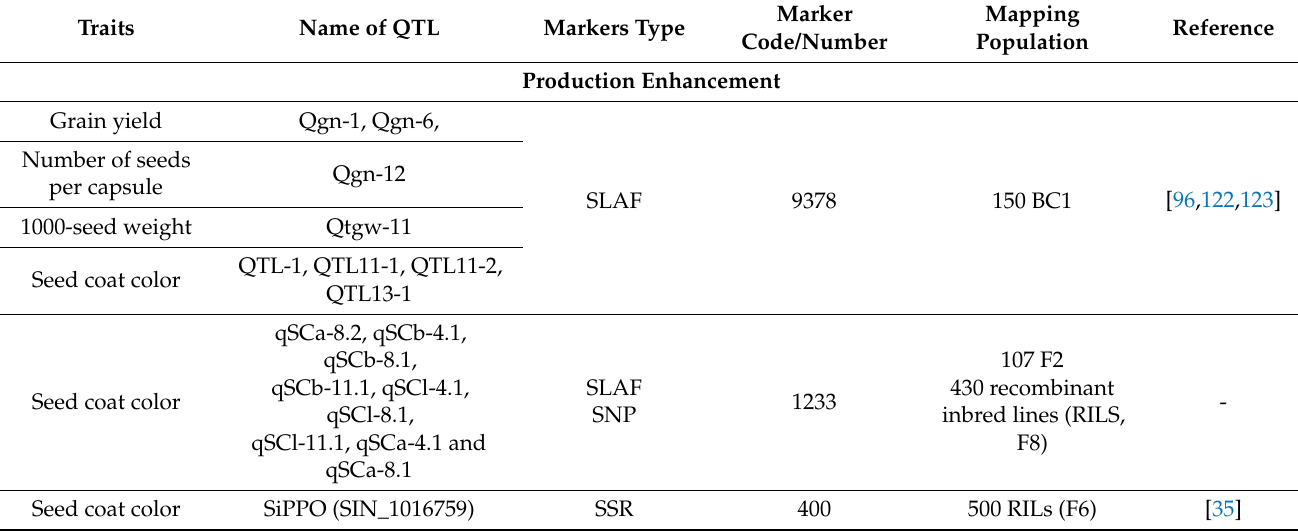
Table 8. Quantitative trait loci (QTLs) and associated phenotypic traits in